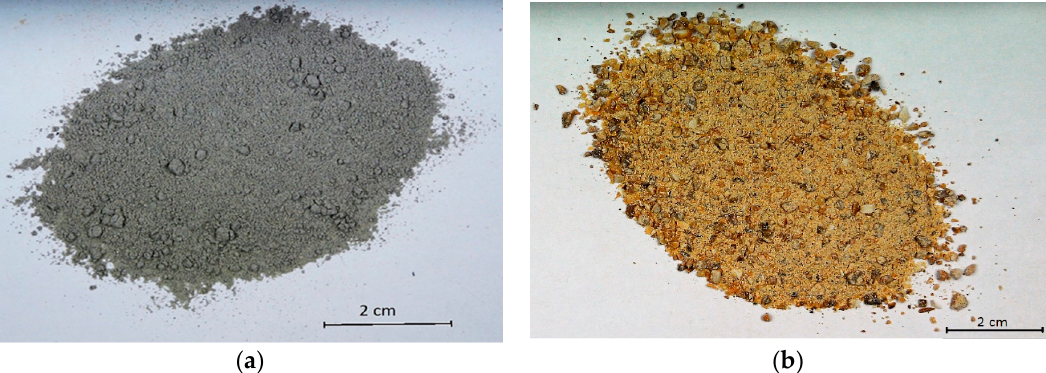
Figure 2. ( a ) Photos of Italian Olivine; ( b ) Reference material after grinding.